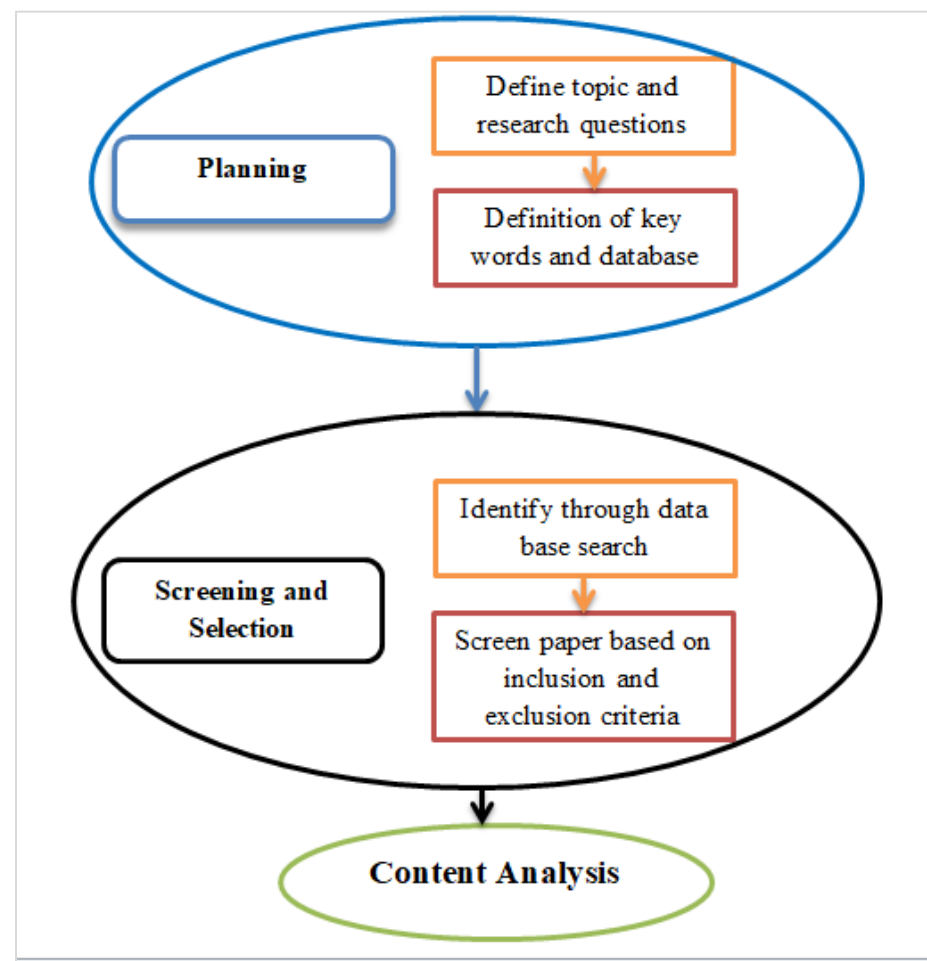
Figure 2. Overview of the methodological approaches adapted from Monteiro et al. [33].